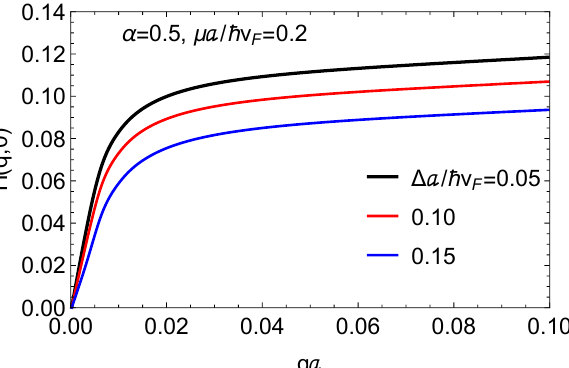
Figure 2. Plots for the static polarization function at T = 0 K as a function of wave number in units of the inverse lattice constant for chosen µ = 0.2¯ hv F / a and hopping parameter α = 0.5. The results are compared for various mass terms ∆